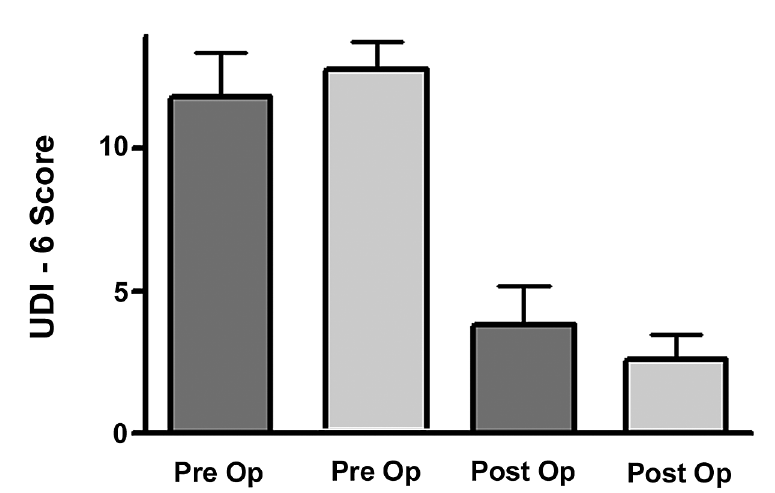
Figure 1 – Mean UDI-6 scores before and after PVS. Group A = dark grey bars; Group B = light grey